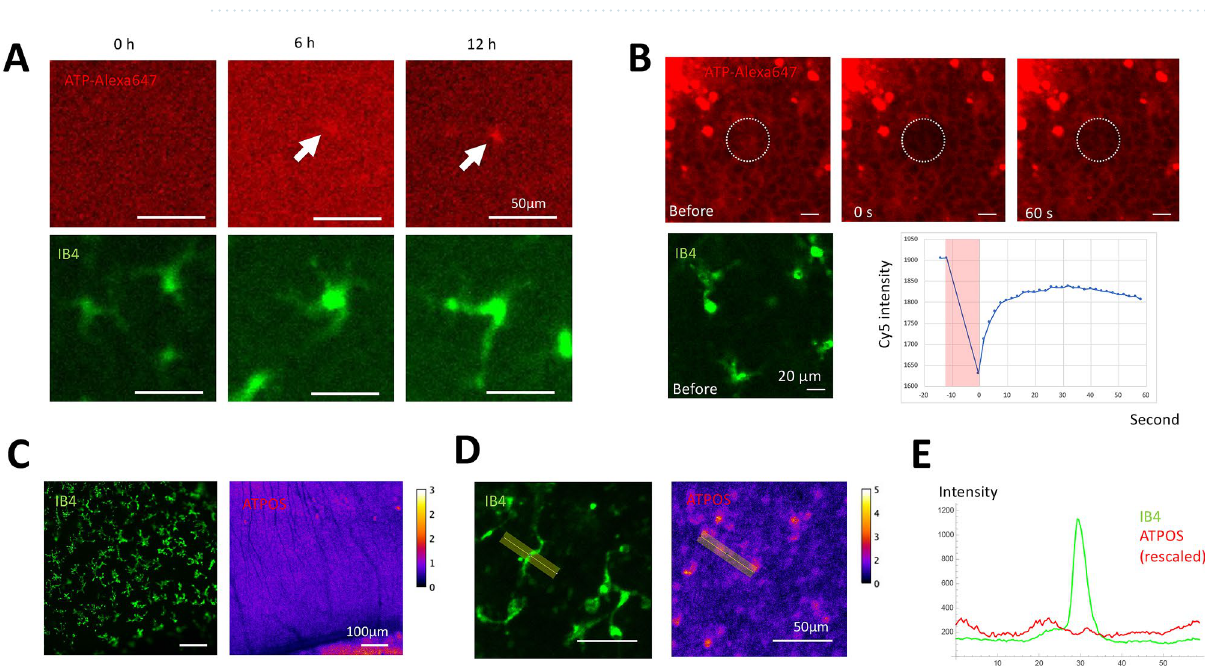
Figure 6. ATP dynamics in mouse retina organ culture. ( A ) ATP uptake of retinal microglia during 12 h. ( B ) Measurement of the ATP diffusion coefficient by FRAP. After the sample was immersed with florescent ATP solution, a small region of the retina was photobleached, and the recovery was observed. ( C – E ) The extracellular distribution of ATP. ( C ) Low magnification view. ( D ) High magnification view. ( E ) Fluorescence intensity ratio around